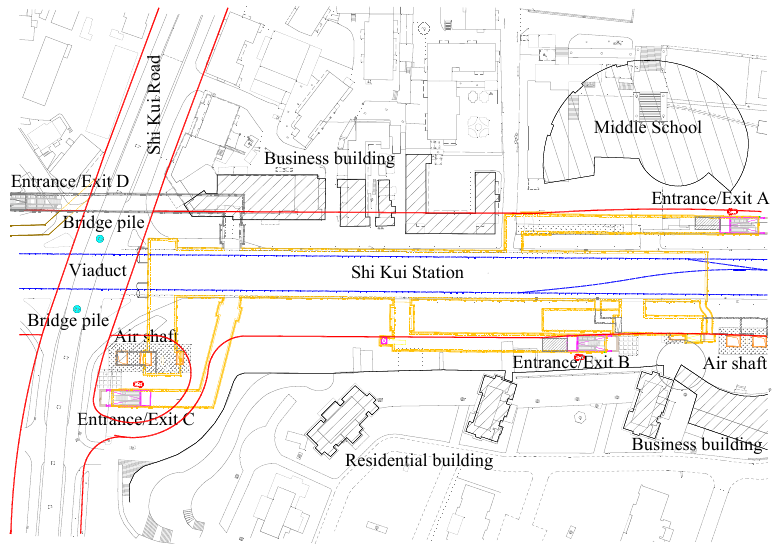
Figure 1. Plan view of Shi Kui Subway Station.